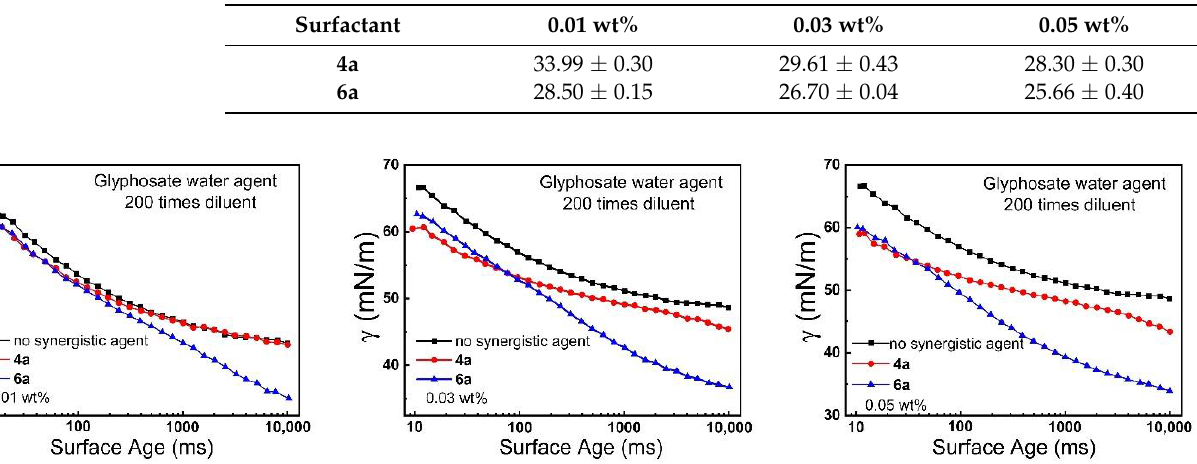
Figure 11. Dynamic surface tension data for aqueous solutions of glyphosate water agent containing surfactants 4a or 6a.